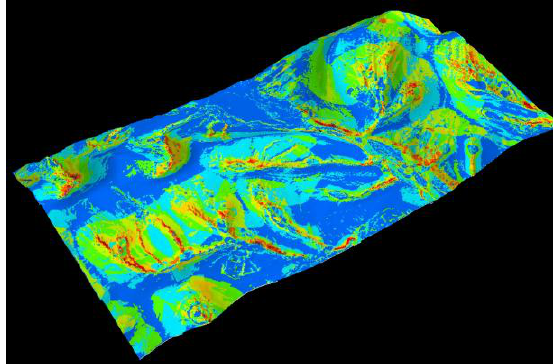
Fig.5a. Spatial view on the landslide susceptibility